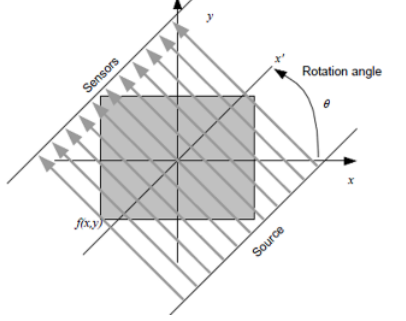
Figure 2. A schematic representation of the Radon projection (Miciak, 2010).